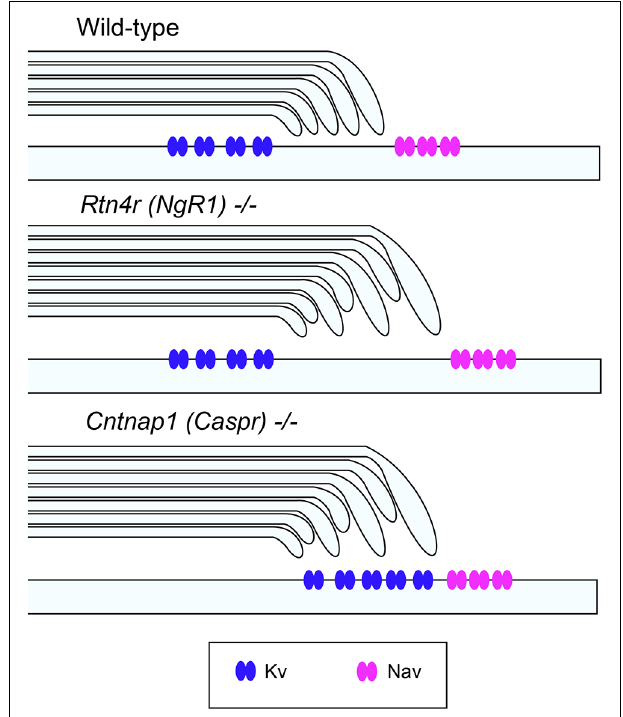
FIGURE 2 | Unaltered ion channel distribution in the axo-myelinic junction of the CNS of ngr1 − / − mice. Schematic representation of the proposed ion channel distribution in the CNS myelinated fibers of wild-type, ngr1 − / − and caspr − / − mice. In caspr − / − , juxtaparanodal Kv channels are displaced and distributed throughout the paranodal region, whereas in ngr1 − / − , although lengthening of paranodal Caspr was found, ion channel distribution could not be identified (Lee et al.,